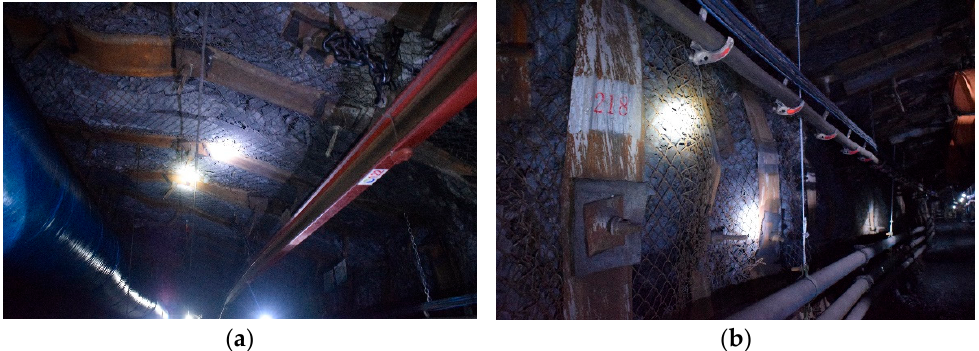
Figure 7. Surrounding rock control effect diagram: ( a ) roof, ( b ) upper